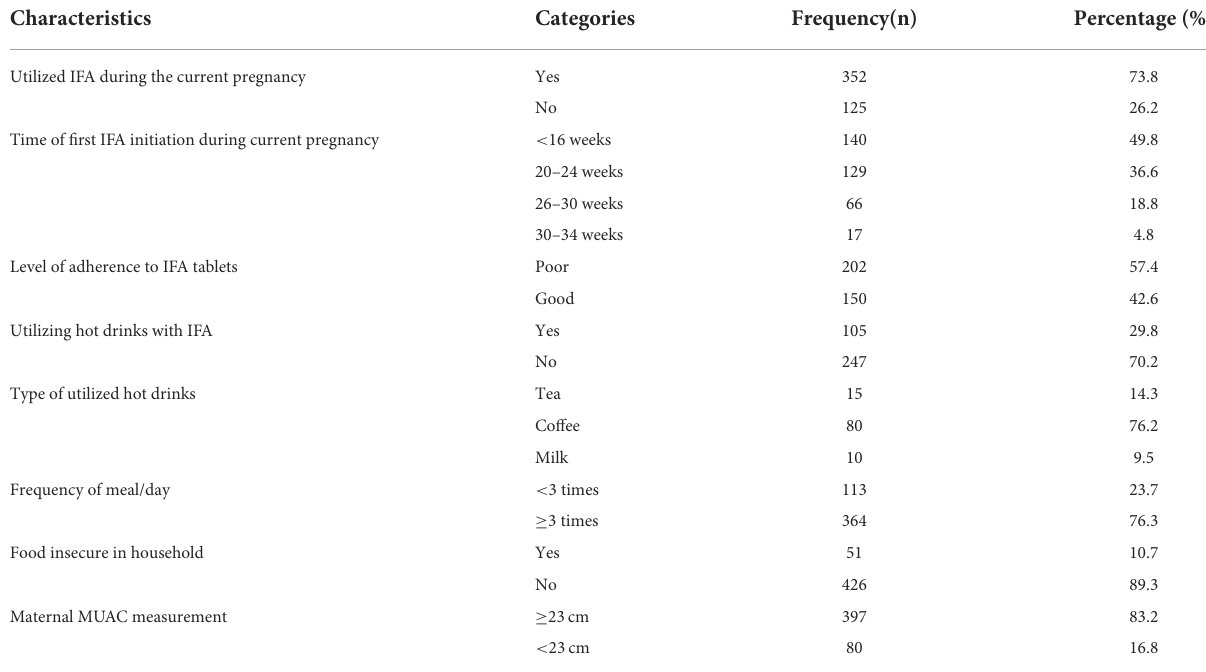
TABLE 3 Dietary and micronutrient-related factors of postpartum women admitted to the maternity ward in public hospitals in Harari Regional State, Eastern Ethiopia, 2021.